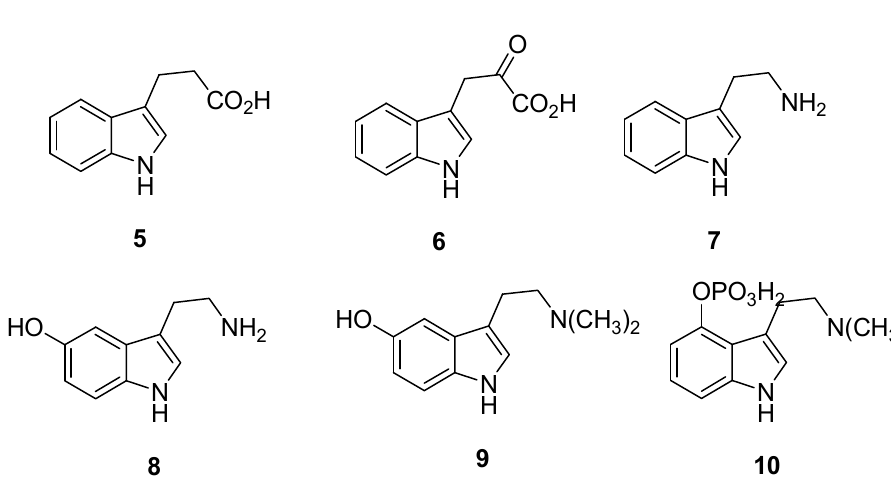
Figure 2. Derivatives of